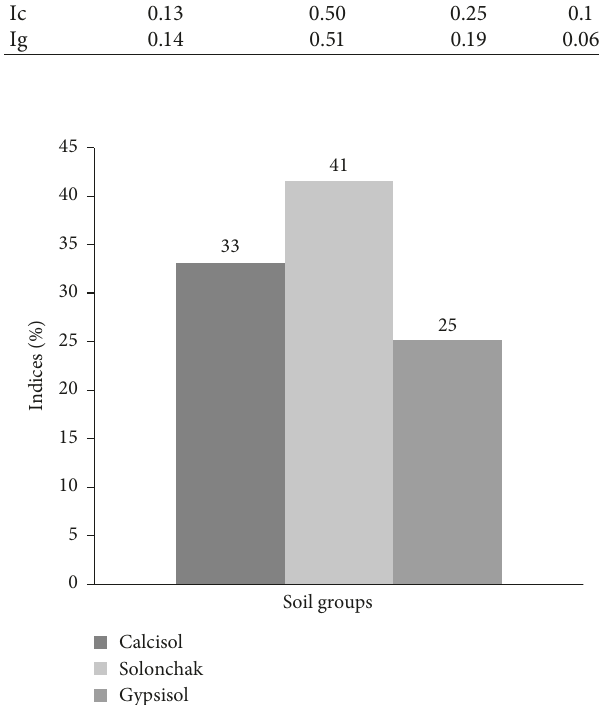
Figure 6: Histogram of frequency